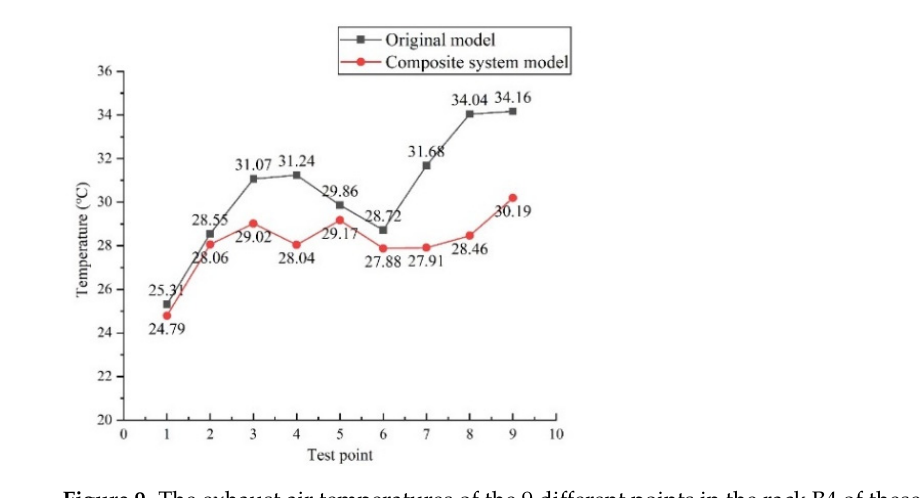
Figure 8. The profile of heat distribution of the back door in rack B4 with the original and new cooling systems.